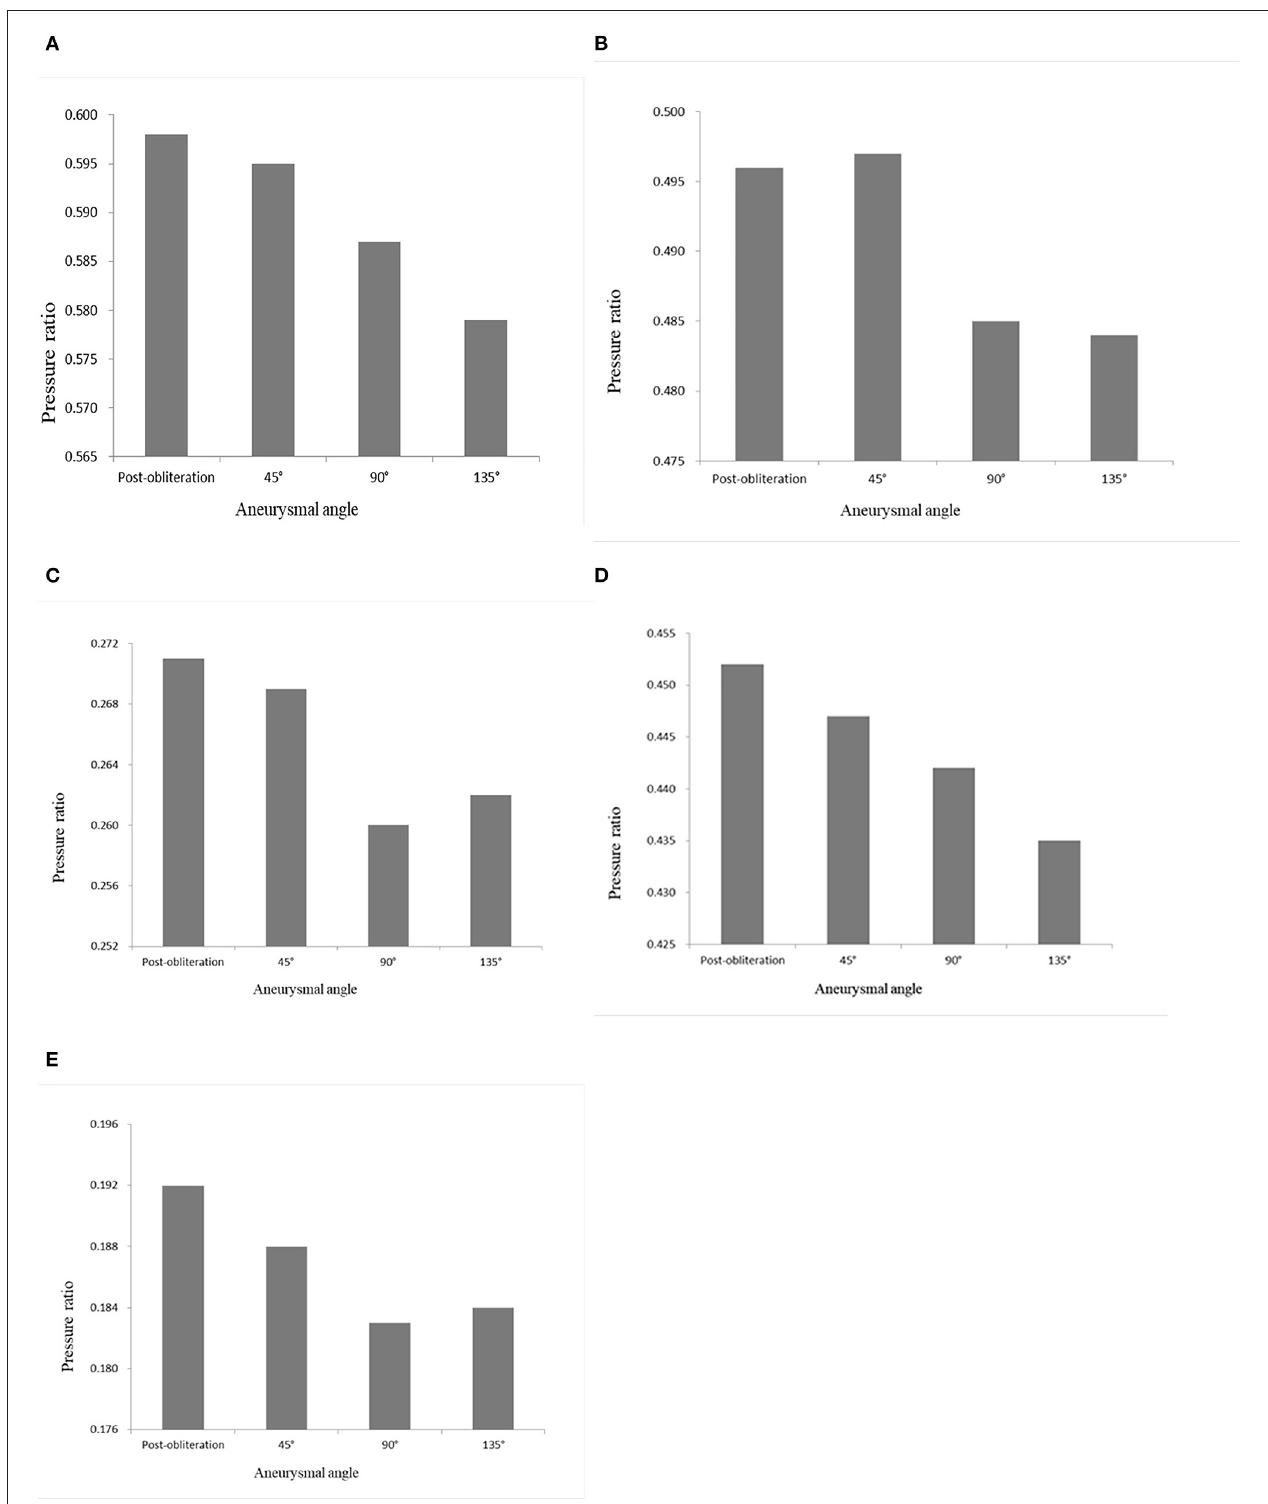
FIGURE 4 | Pressure ratio of the models with aneurysmal angles of 45 ◦ , 90 ◦ , 135 ◦ , and the no-aneurysm model. (A) A1 segment. (B) A2 segment. (C) A3 segment. (D) M1 segment. (E) M2 + M3 segments.